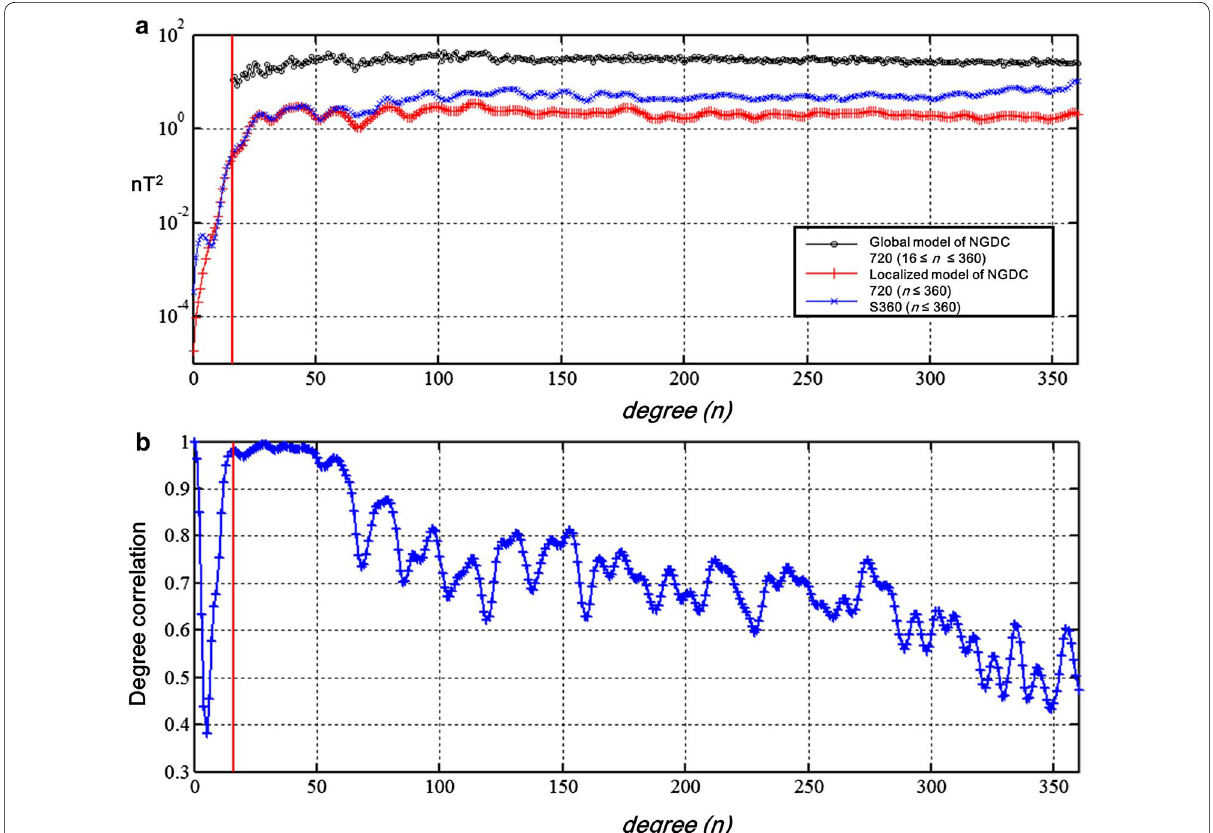
Fig. 5 a Lowes–Mauersberger power spectra of the band-limited (16 ( red crosses ) and S360 models ( blue x’s) up to degree n models. The red solid vertical line on both panels marks n